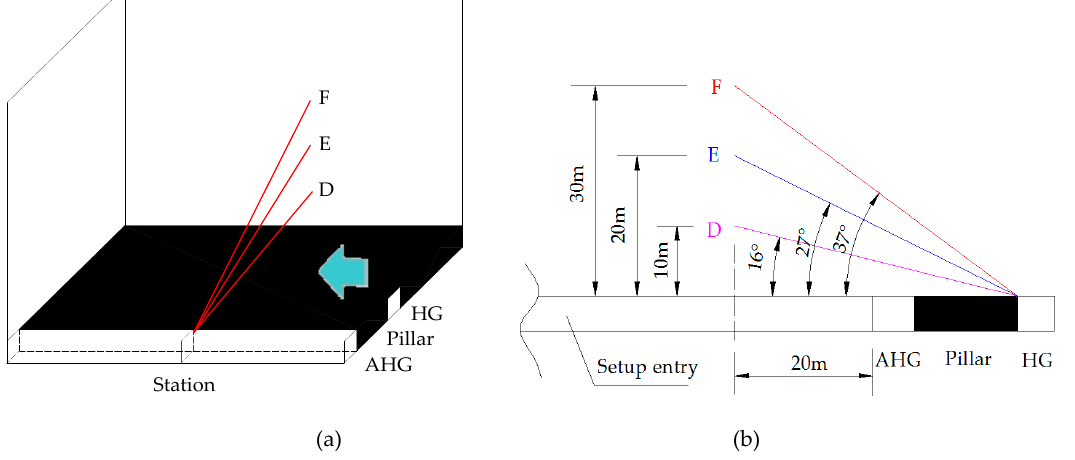
Figure 4. Drillholes design in AHG: (a) Spatial distribution diagram; (b) Sectional view.